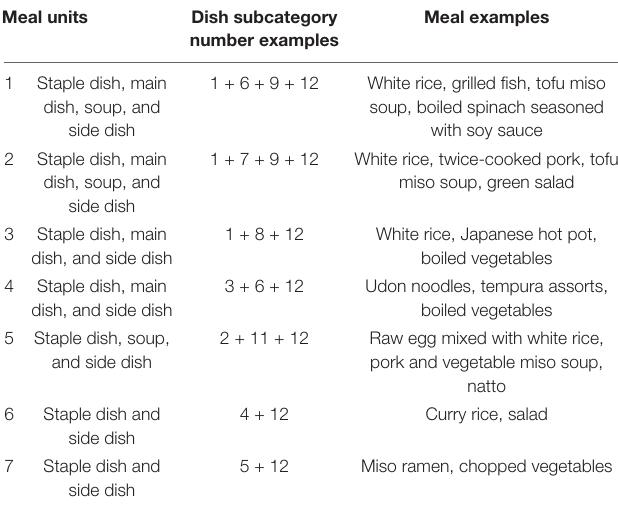
TABLE 2 | Generated Japanese meal units for developing the Ajinomoto Group Nutrient Profiling System (ANPS). Meal units Dish subcategory Meal number examples